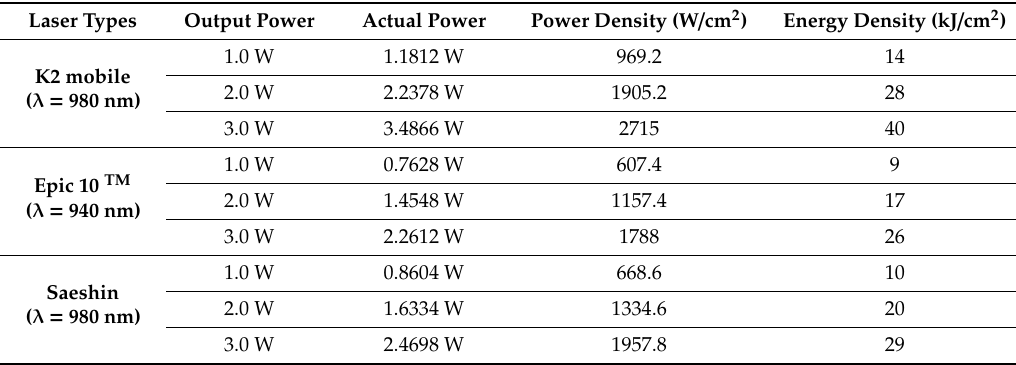
Table 1. Parameters of three dental diode